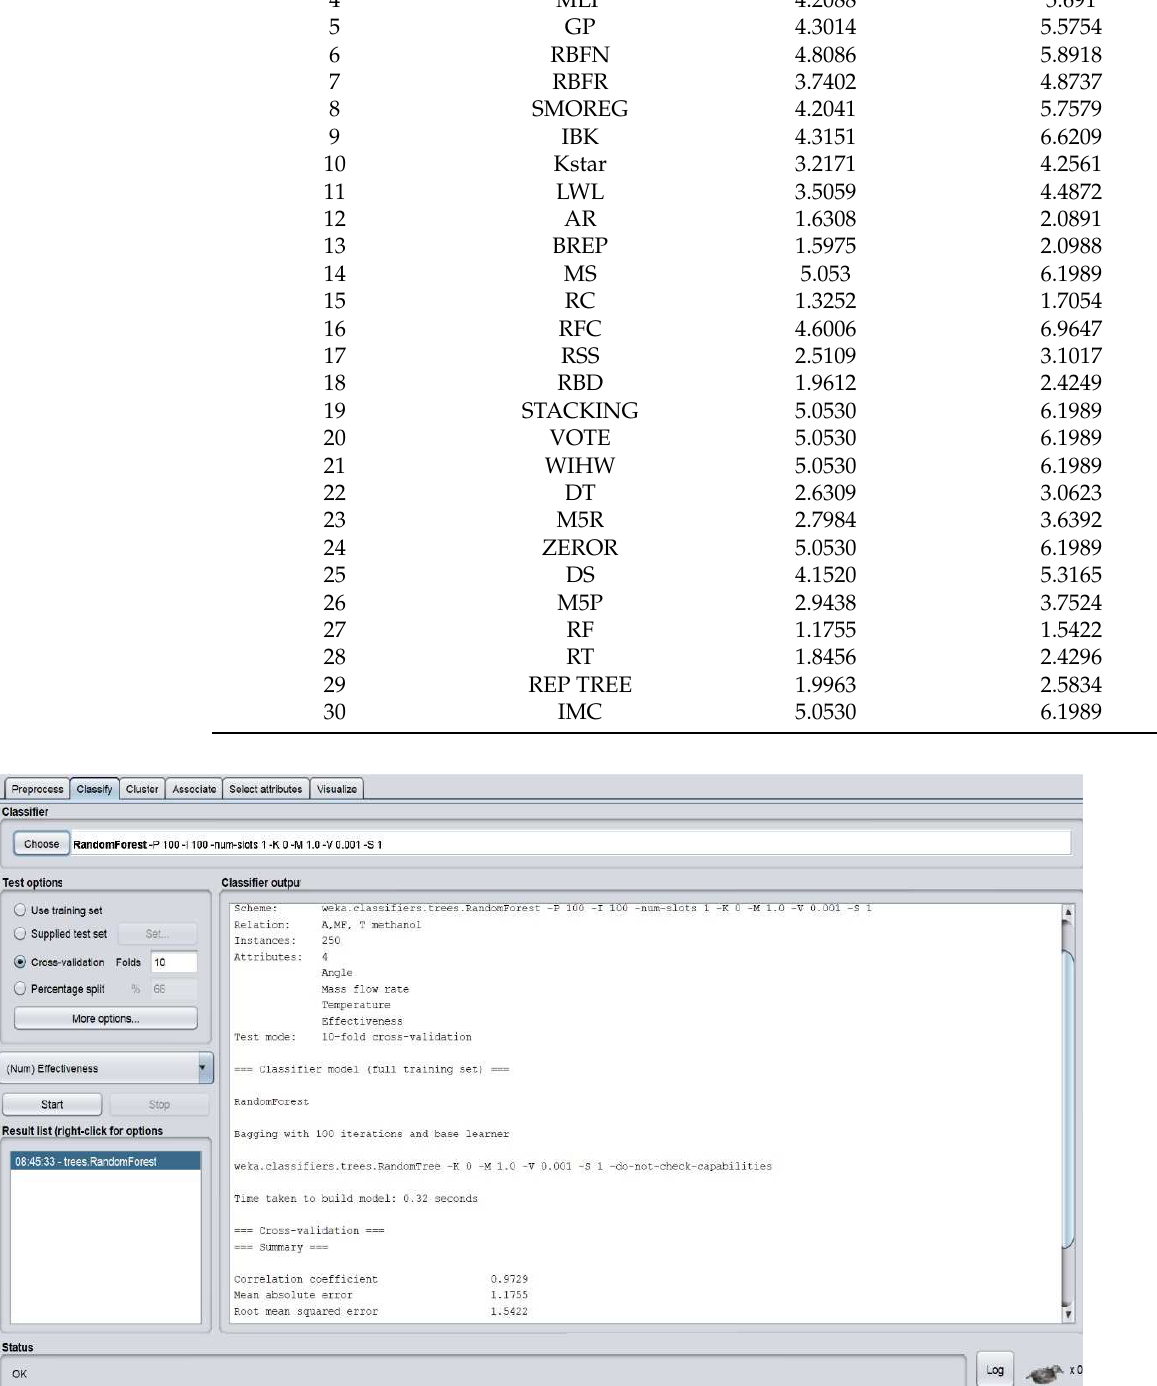
Figure 6. Random forest algorithm. The scatter plots of the predicted versus the experimental values for the various anal-